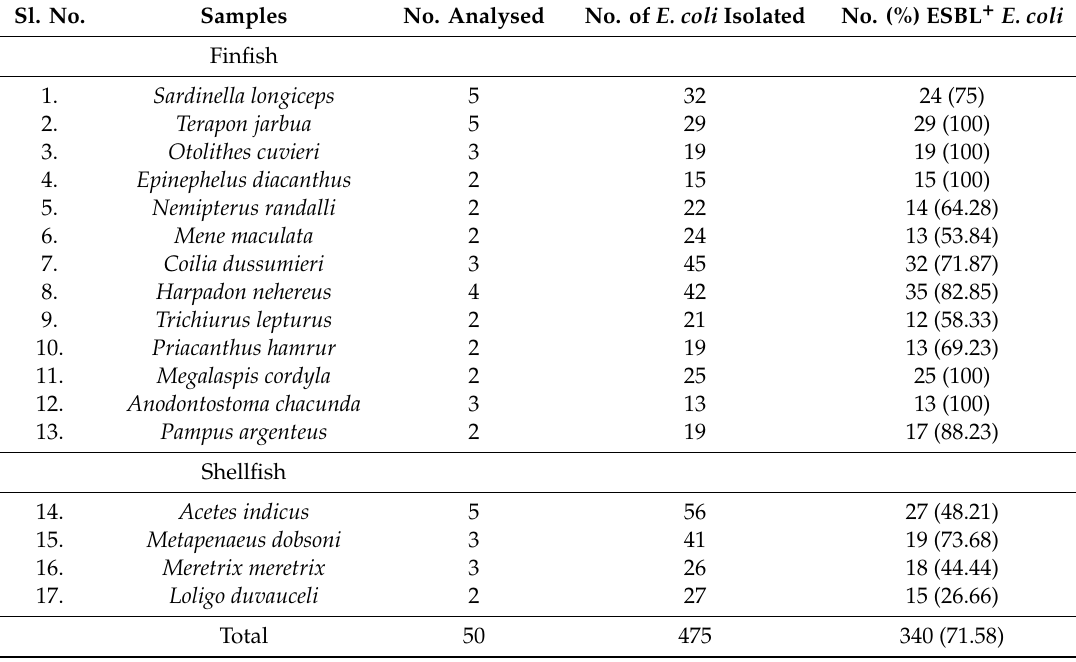
Table 1. Sample-wise distribution of Escherichia coli and ESBL +